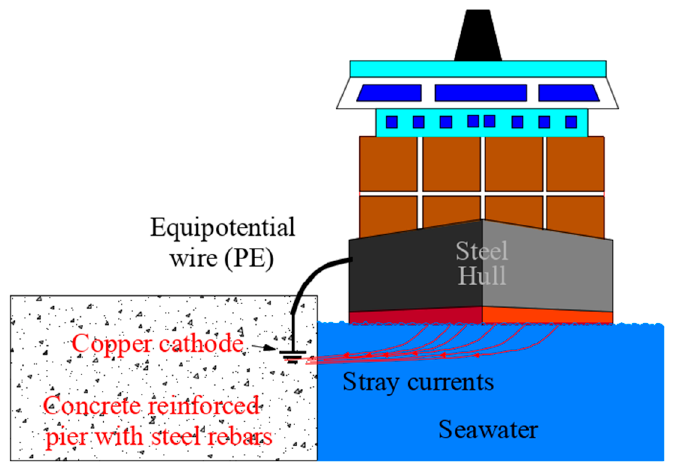
Figure 6. Galvanic cell created by elements of the ship’s hull, the pier and the seawater.